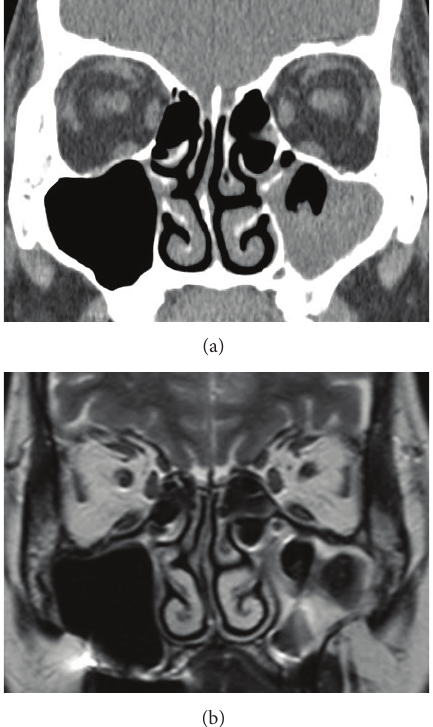
Figure 1: Typical neuroimaging findings of maxillary fungus ball. (a) Coronal CT scan with soft tissue density. Left maxillary sinus is completely filled with material. High density spots are seen. (b) Coronal T2-weighted MR image. Extremely low signal intensity to signal void indicates the presence of fungus ball. Peripheral high intensity area indicates edematous mucosa.